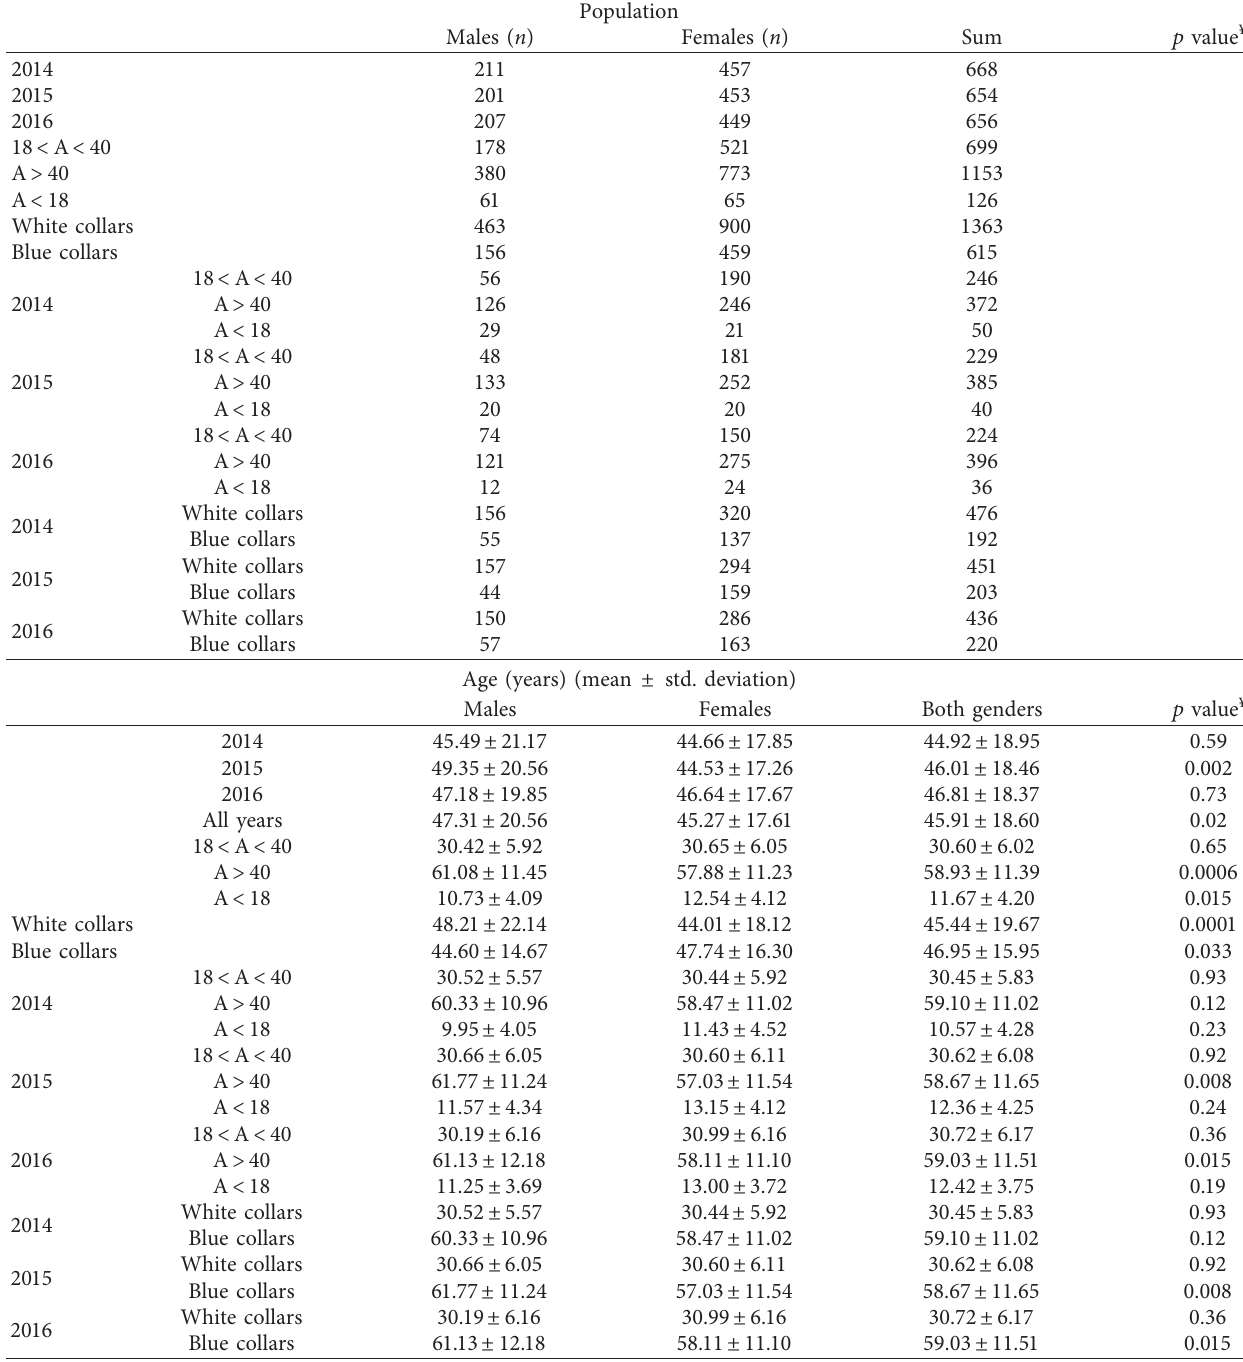
¥ p value indicates differences between male and female